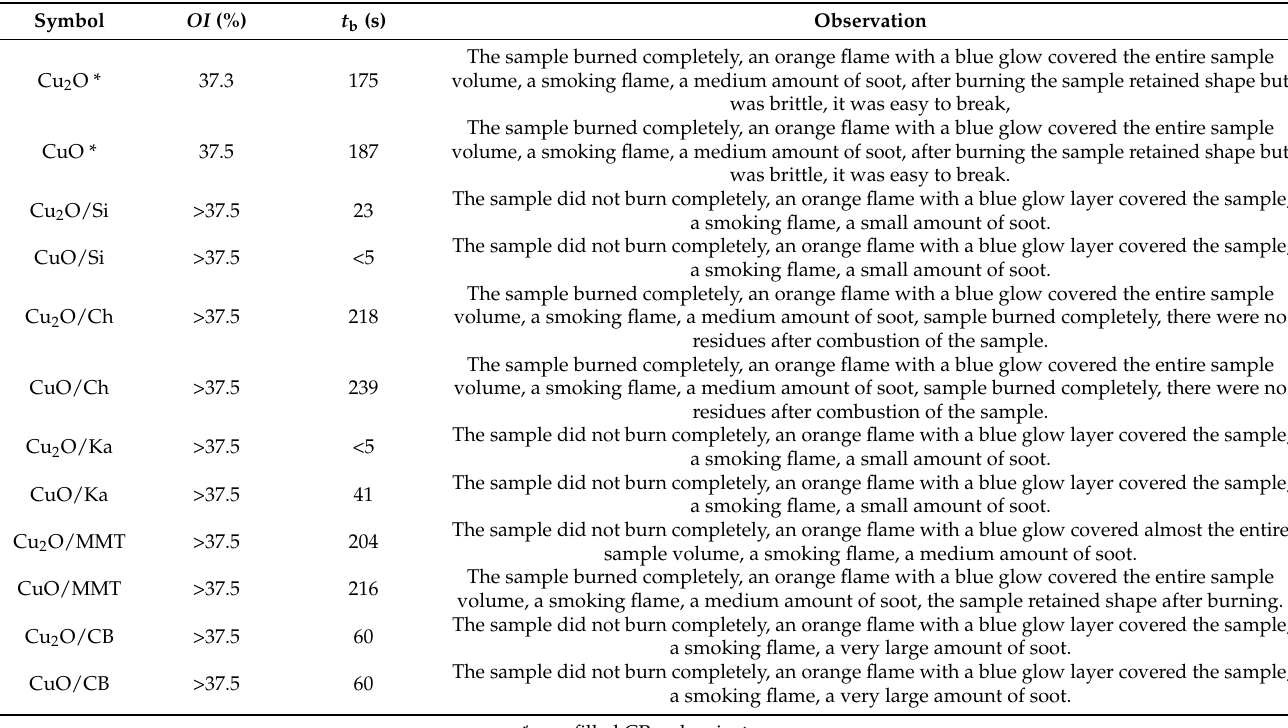
Table 6. Flammability of filled CR vulcanizates; T = 160 ◦ C, t = 45